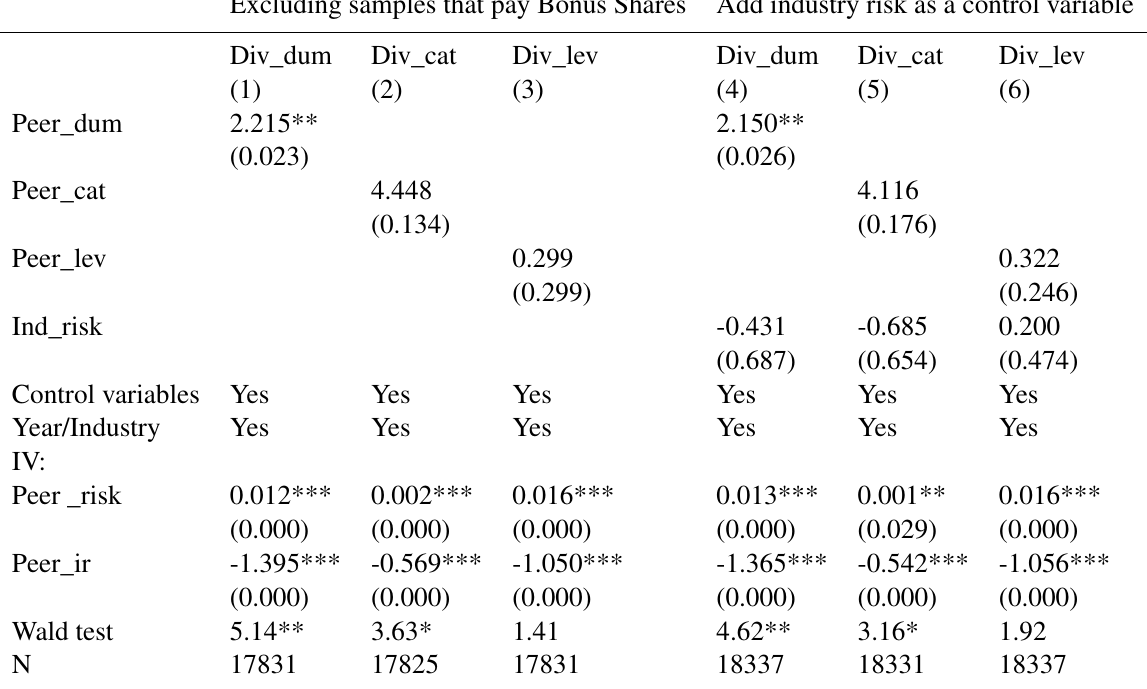
Table 6 Robustness test of 4.4.1 and